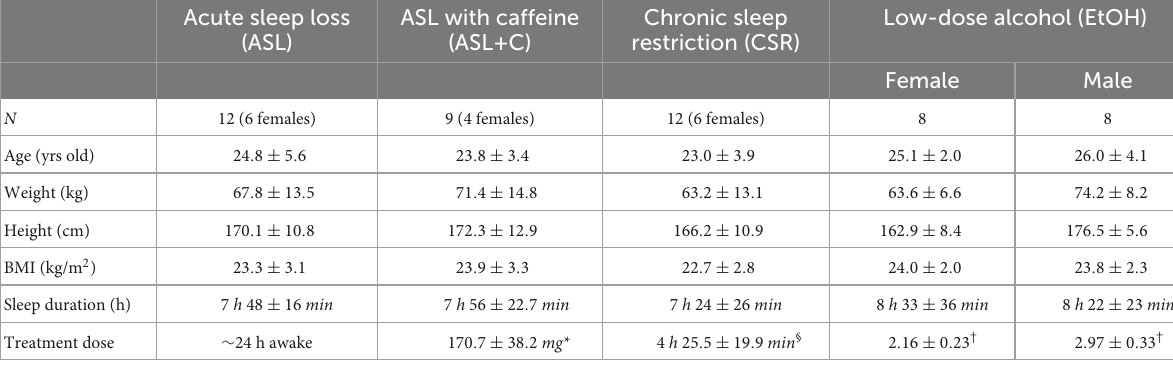
TABLE 1 Participant demographics and treatment conditions (mean ±